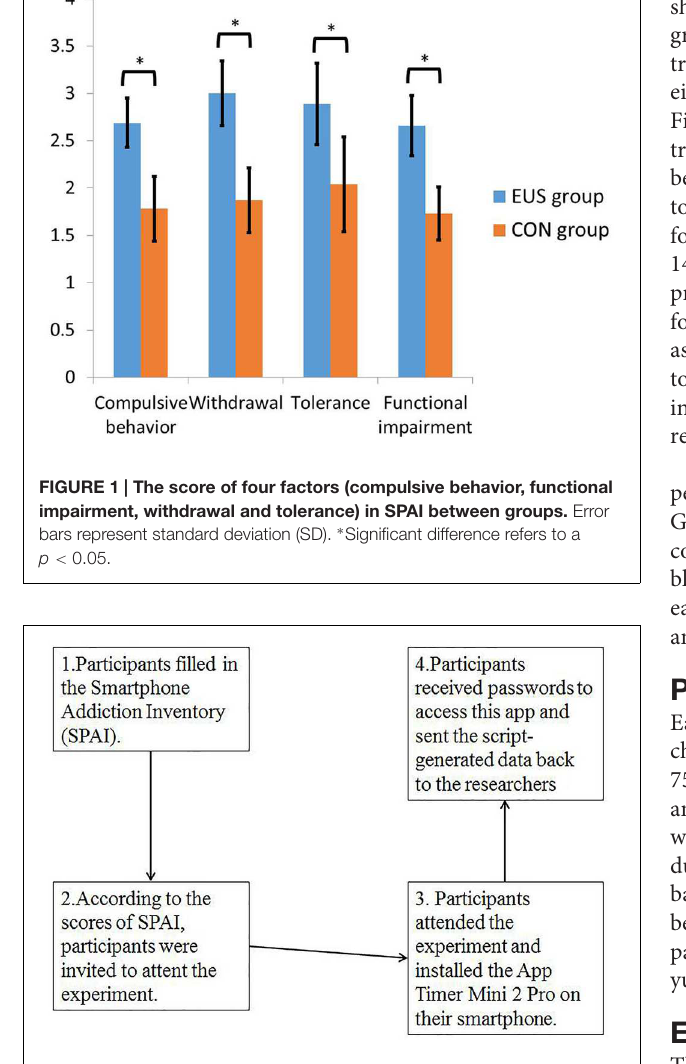
FIGURE 2 | The flowchart depicting the participants